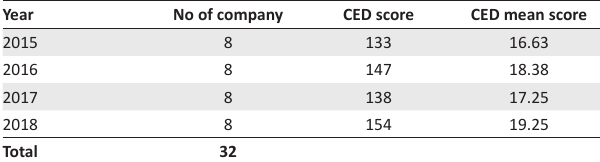
TABLE 2: Overall corporate environmental disclosure index on annual